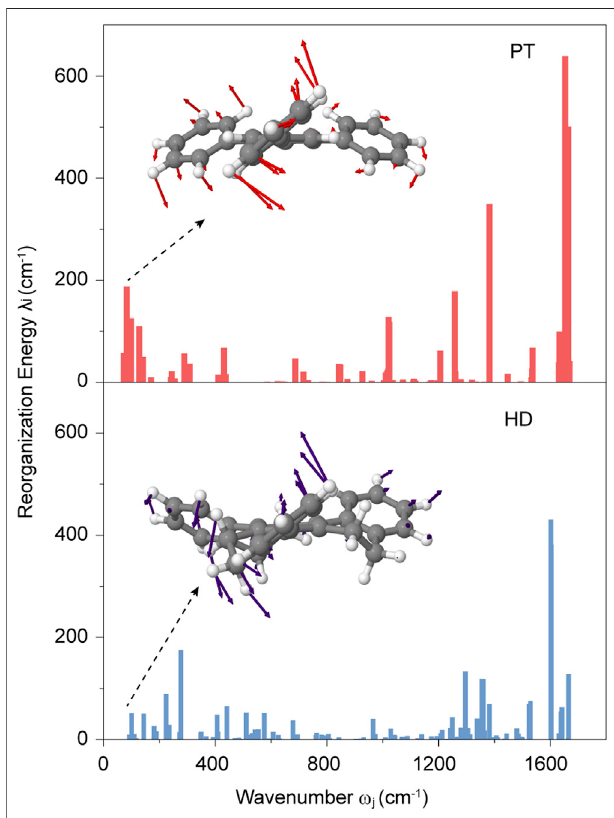
FIGURE 3 | Calculated reorganization energy λ j of T 1 → S 0 for PT and